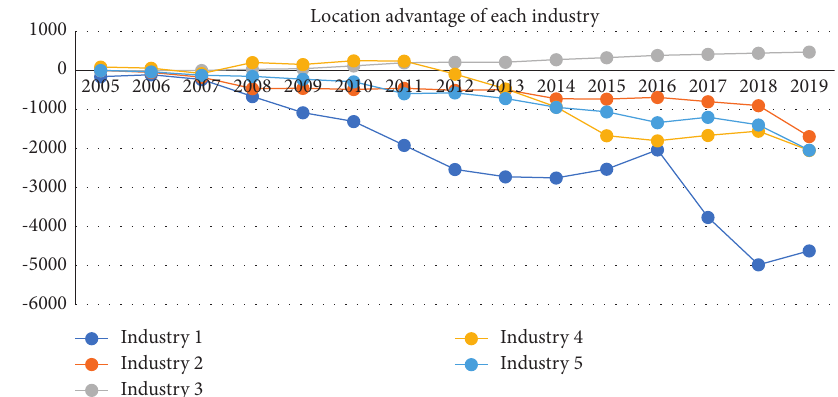
Figure 8: Location advantage of each industry.